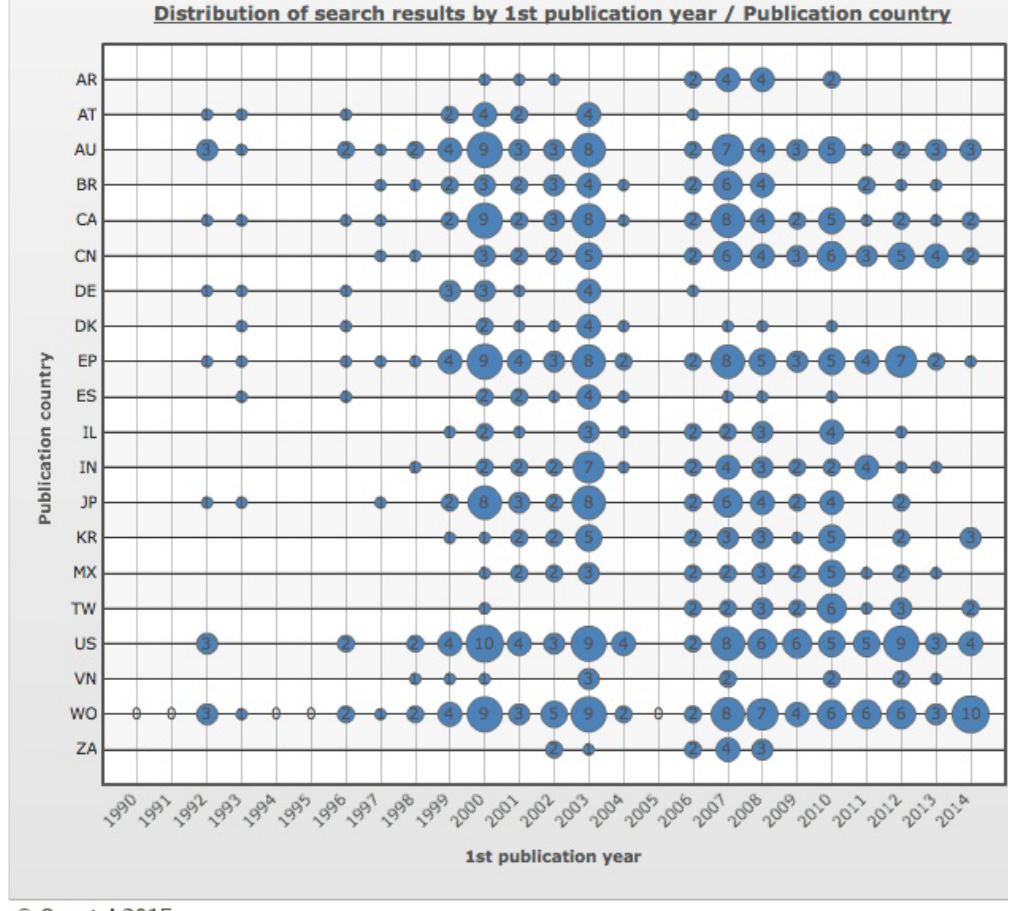
Figure 4. Distribution of search results by correlation between first publication year and top 20 publication countries from 1990 to 2014. AR: